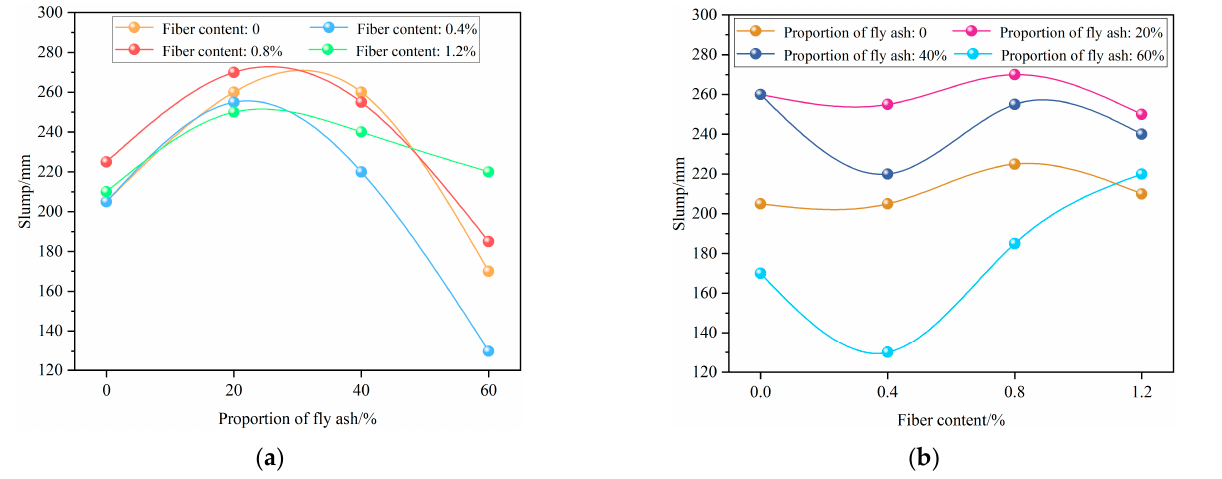
Figure 4. Influence of the FA ( a ) and SF ( b ) contents on the